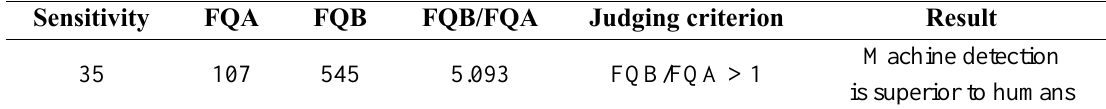
Table 2. Knapp-Kushner testing